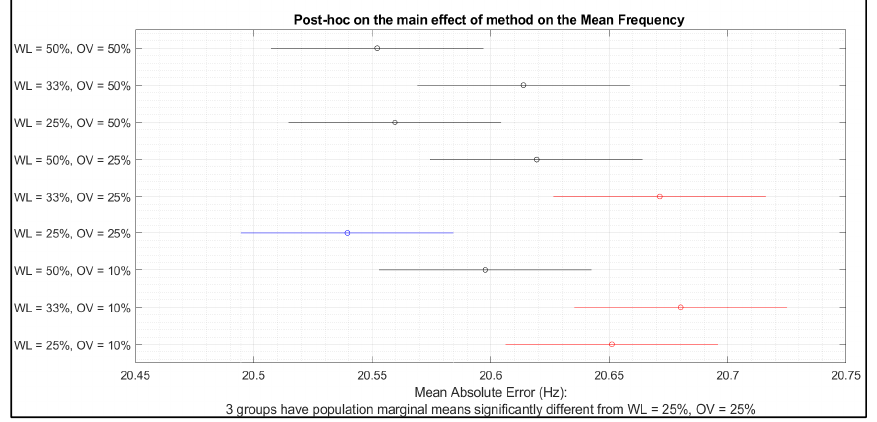
Figure A1. Post ‐ hoc test on the main effect of the method factor on the Mean Frequency. Significance was set at 5%. Blue color shows the Window Length (WL) ‐ Overlap (OV) combination that we want to compare with the others. In black are represented all the combinations whose mean is not statistically different ( p > 0.05) from that one in blue. In red are represented all the combinations whose mean is statistically different ( p < 0.05) from the one in blue. We noticed that the combination window length equal to 25% of the total signal length and overlap equal to 25% of the window length itself produced the minimum error that was significantly different from other three combinations. Since similar results were obtained in the analysis of the median frequency, we selected this particular combination (WL = 25%, OV = 25%) of settings for the Welch method and compared this one with the orders of the autoregressive model. References 1.